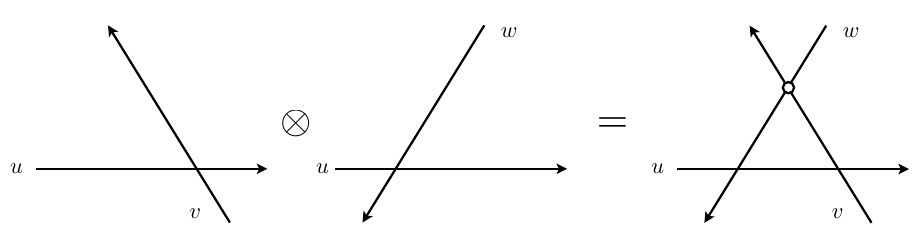
Figure 8 . Binding the left and right interactions in a decoupling friendly way (cid:12)xes the third vertex, here shown as a blob, to be a shifted R